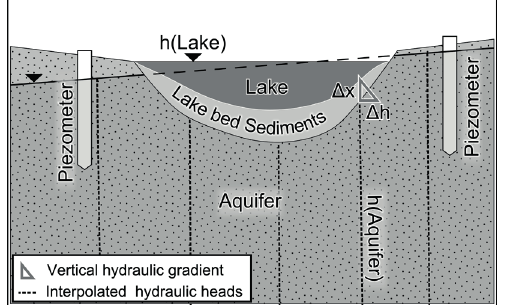
Fig. 1 Conceptual drawing of the estimation of spatially distributed VHGs. Hydraulic heads are spatially interpolated between piezometers (h(Aquifer)) and then subtracted by the lake level (h(Lake)). VHGs are estimated by dividing differences in hydraulic heads ( ∆ h) by the thickness of the lake bed sediments ( ∆